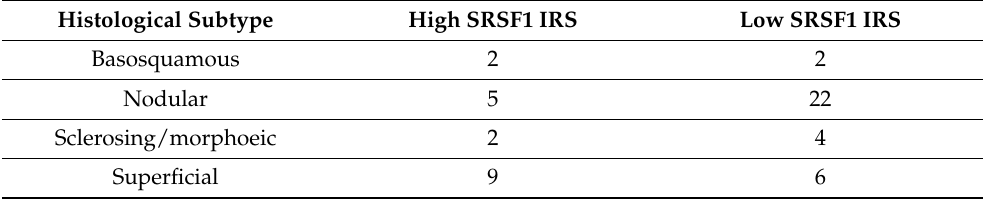
Table 5. Distribution of histological subtypes according to SRSF1